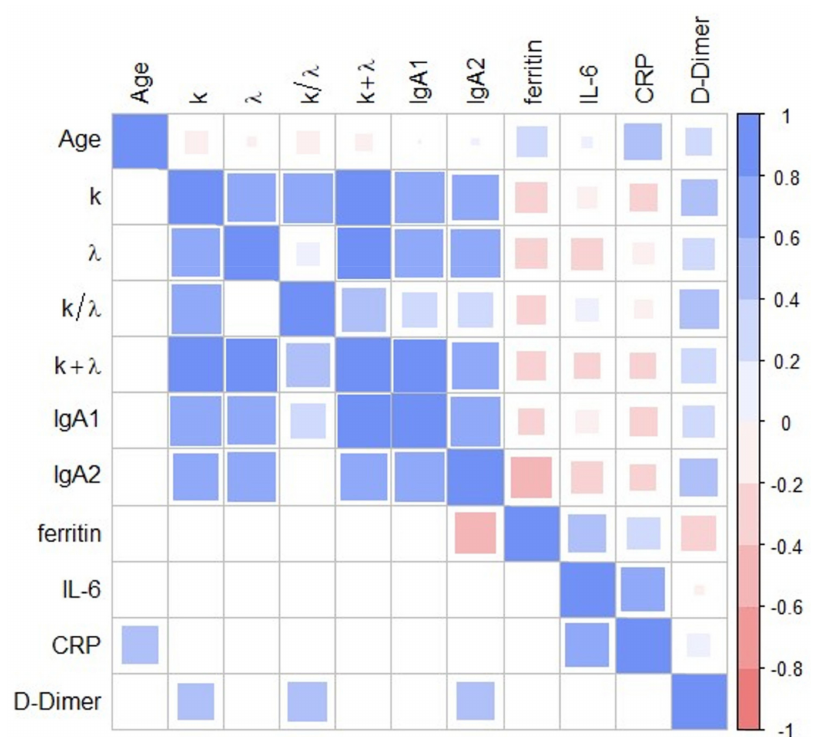
Figure 4. Heat map of Spearman’s correlation coefficients between salivary (FLCs and IgAs) and blood (ferritin, IL-6, CRP, D-Dimer) biomarkers. All the calculated correlations are plotted above the main diagonal and the significant ones below the main diagonal ( α =